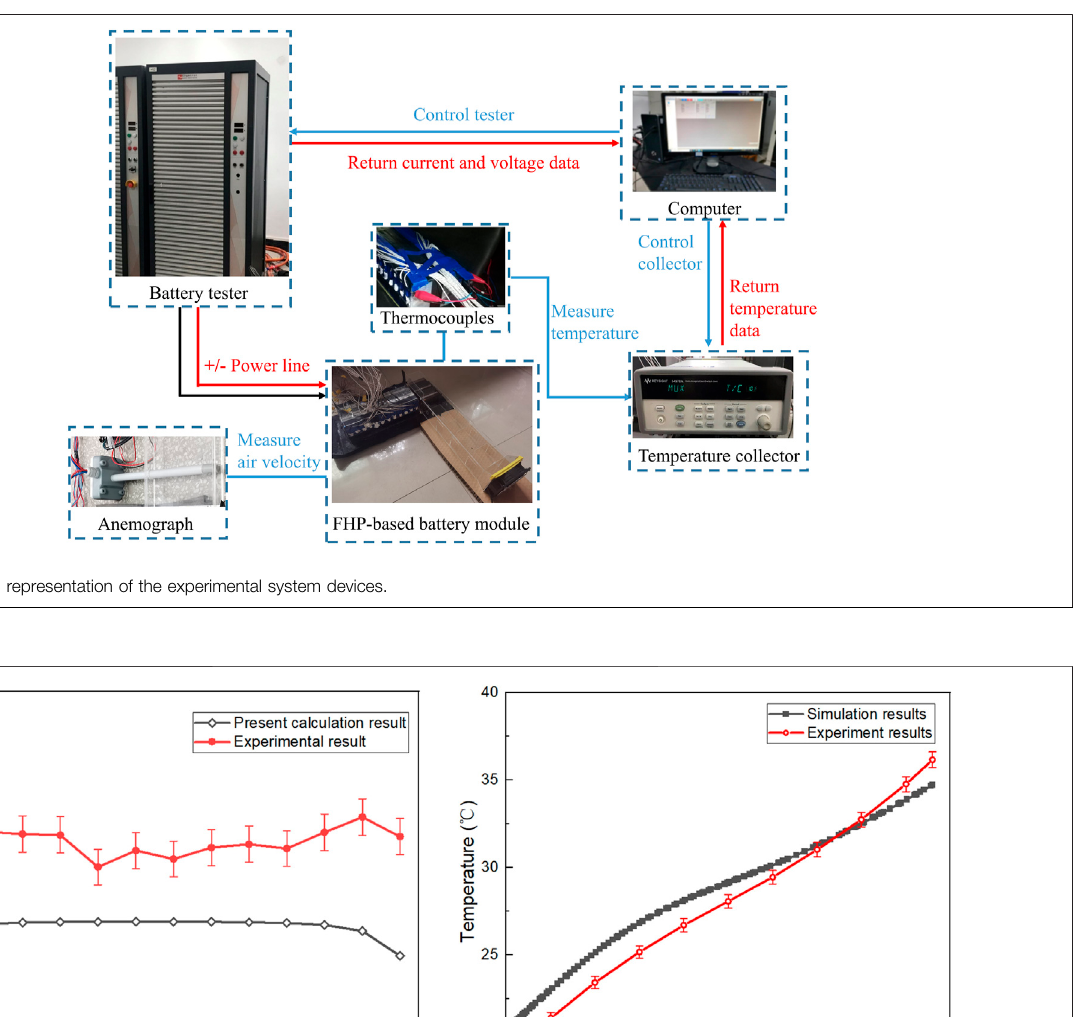
Frontiers in Energy Research |